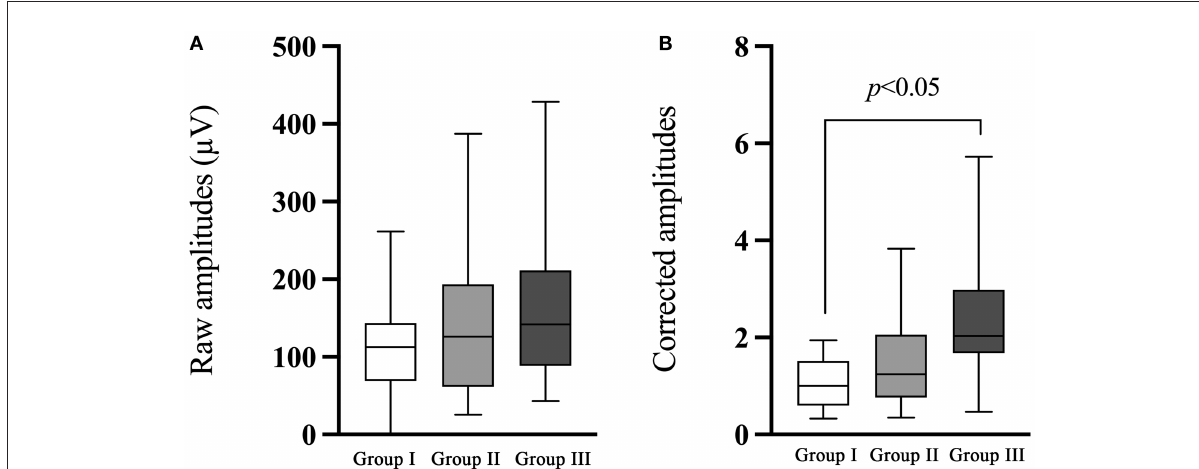
FIGURE5 Comparison of the raw and corrected amplitudes of BCV-cVEMP. (A) The comparison of the raw amplitude of BCV-cVEMP. (B) The comparison of the corrected amplitude of BCV-cVEMP. The white box plot represented group I ( n = 22 ears), light gray box plot represented group II ( n = 21 ears), dark gray box plot represented group III ( n = 40 ears). There was no significant difference of BCV-cVEMP in the raw or corrected amplitude between group I and group II, or in raw amplitude between group I and III. A significant difference existed in the corrected amplitude between group I and III. In this study, no parameter comparison was made between group II and group III. Group I: Normal hearing ears from infants; Group II: Sensorineural hearing loss ears from infants; Group III: Normal Hearing ears from